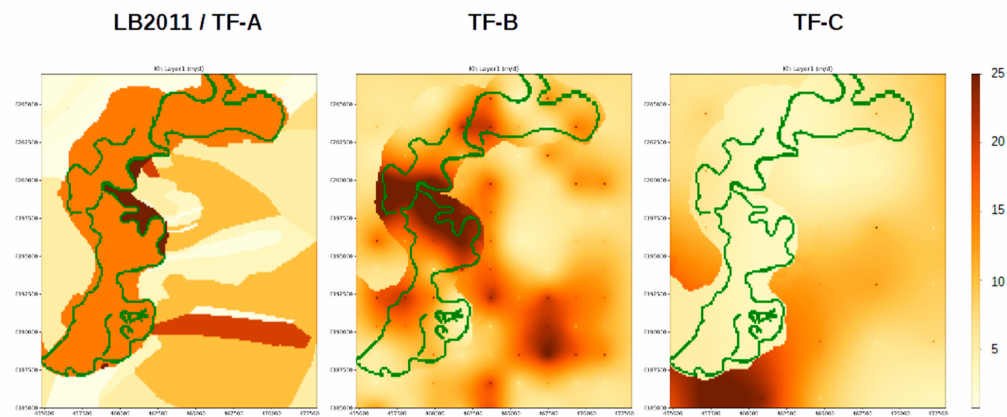
Figure 6. Comparison of calibration for horizontal hydraulic conductivity (m / d) of the Loxton Sands (regional water table aquifer) for the three models evaluated: LB2011 / TF-A model, TF-B model, TF-C model.